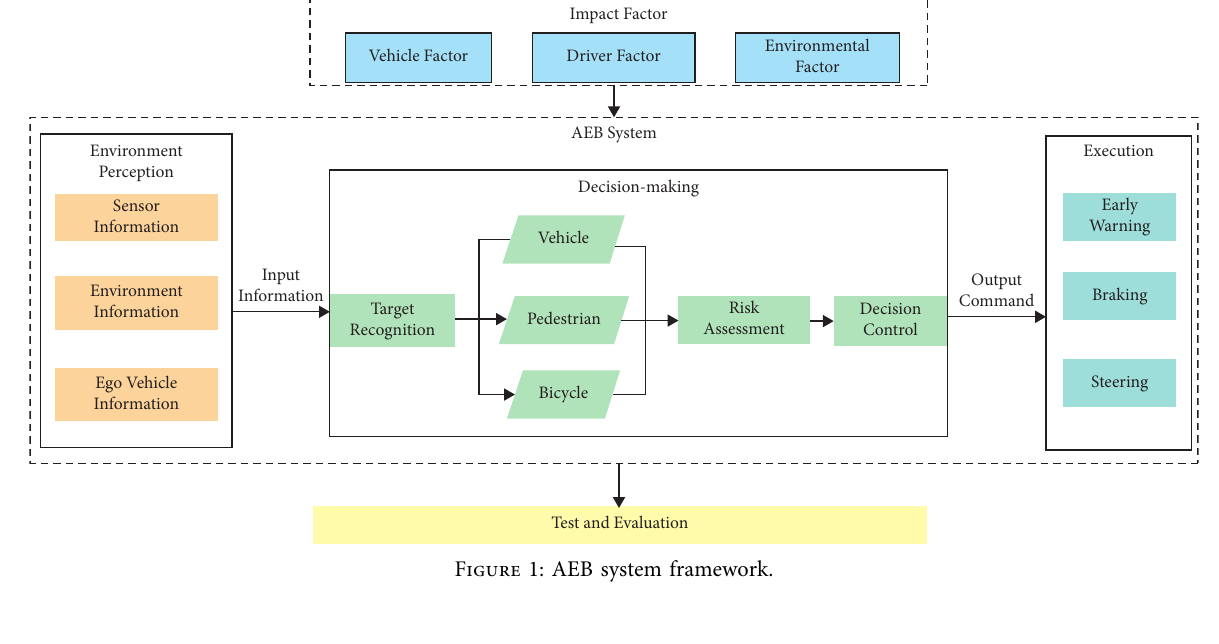
Figure 1: AEB system framework.